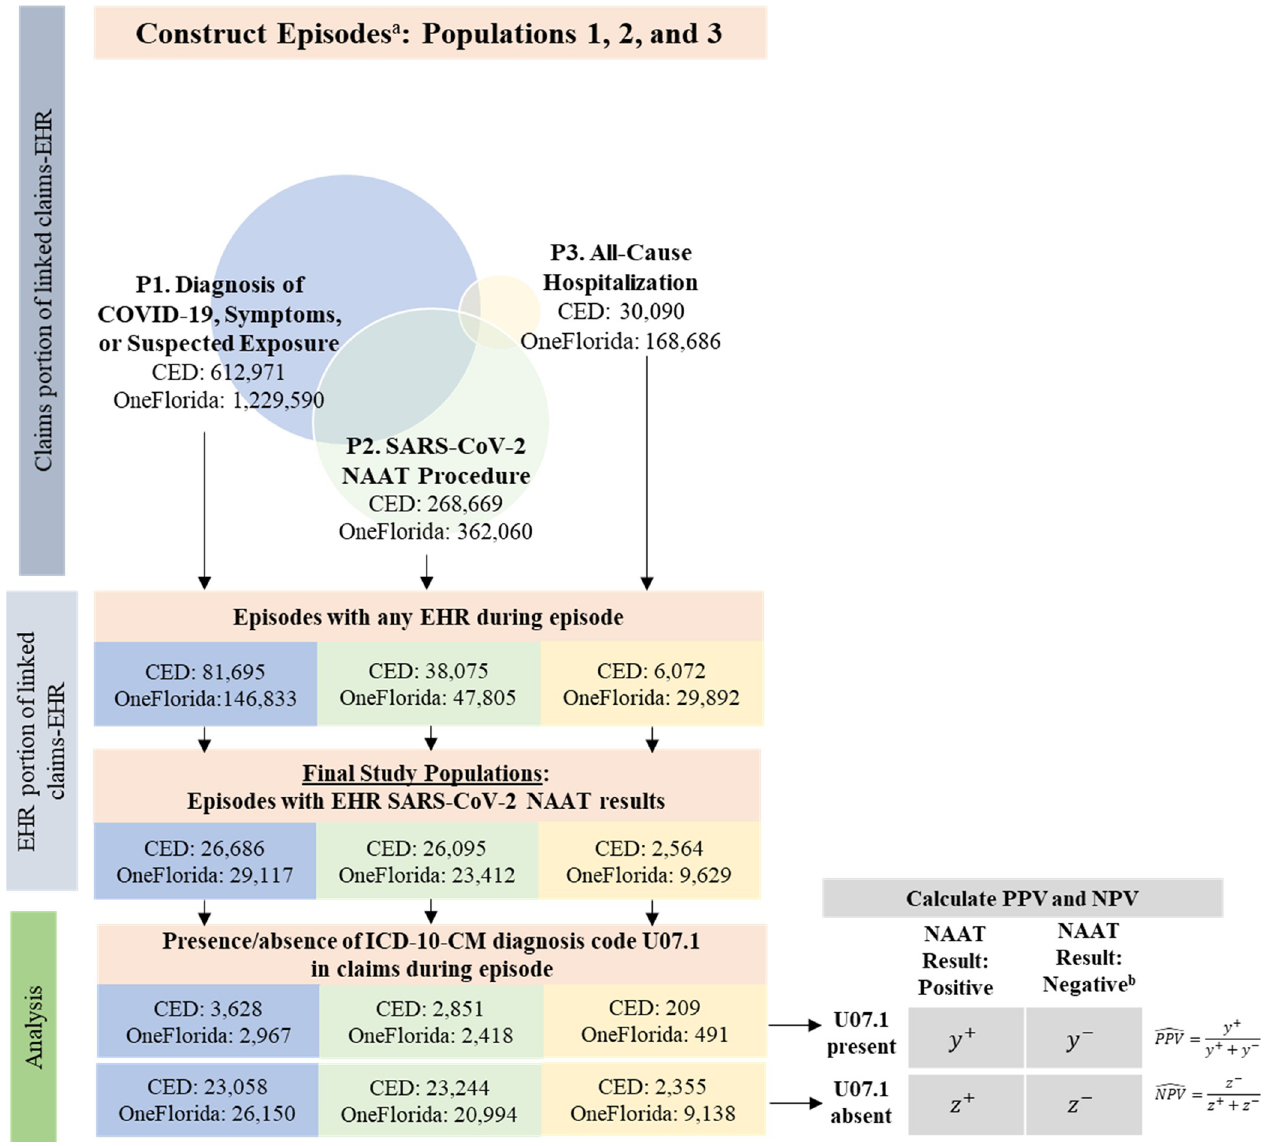
Fig 1. Study flow diagram to identify care episodes for study populations from the linked claims-EHR databases. CED IBM MarketScan Explorys Claims- EMR Data Set, EHR electronic health record, ICD-10-CM International Classification of Diseases, Tenth Revision, Clinical Modification, NAAT nucleic acid amplification test, P population, SARS-CoV-2 severe acute respiratory syndrome coronavirus 2. a Episodes constructed in the claims portion of the linked claims-EHR data are of individuals aged < 65 years at the index event with continuous coverage of medical benefits (allowing for a coverage gap up to 31 days) during the episodes and 6 months prior to the start of the episodes. b When multiple NAATs were present during the episode in the EHR, all must be negative. Data sources: IBM MarketScan Explorys Claims-EMR Data Set, April 1–December 31, 2020, and OneFlorida Data Trust linked Medicaid-EHR,